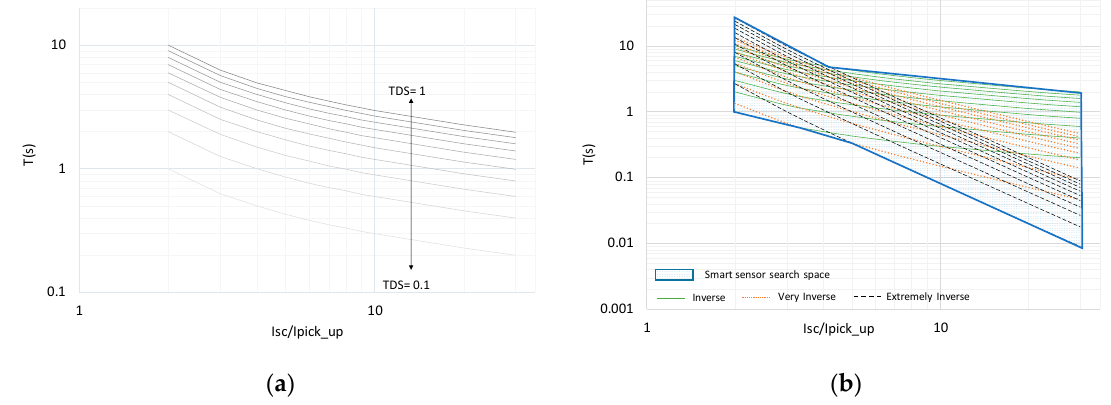
Figure 4. Time-current characteristics: ( a ) adaptive protection; ( b ) smart sensor .